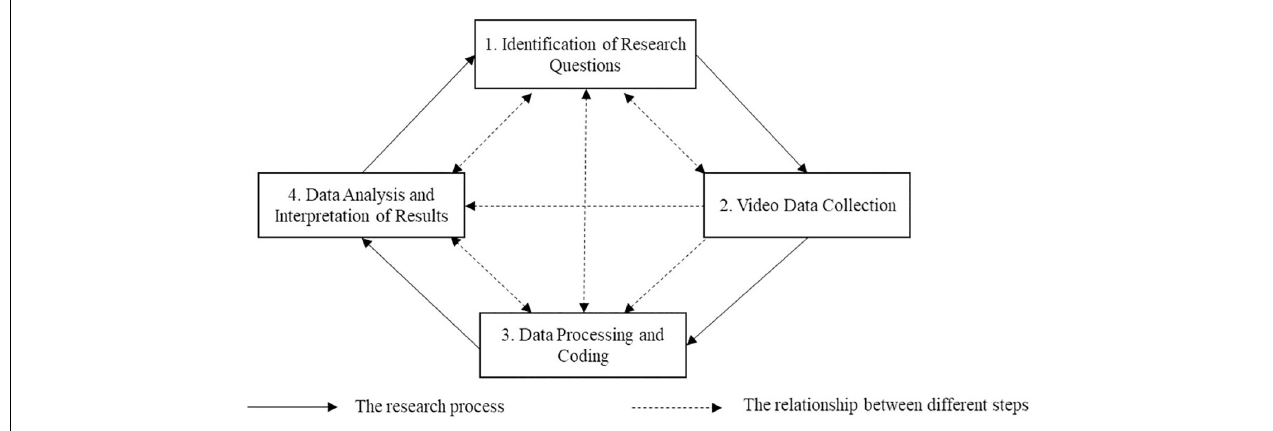
FIGURE 1 | The research processes of behavior observation and coding analysis and the relationship between each step (designed by the authors of this study).